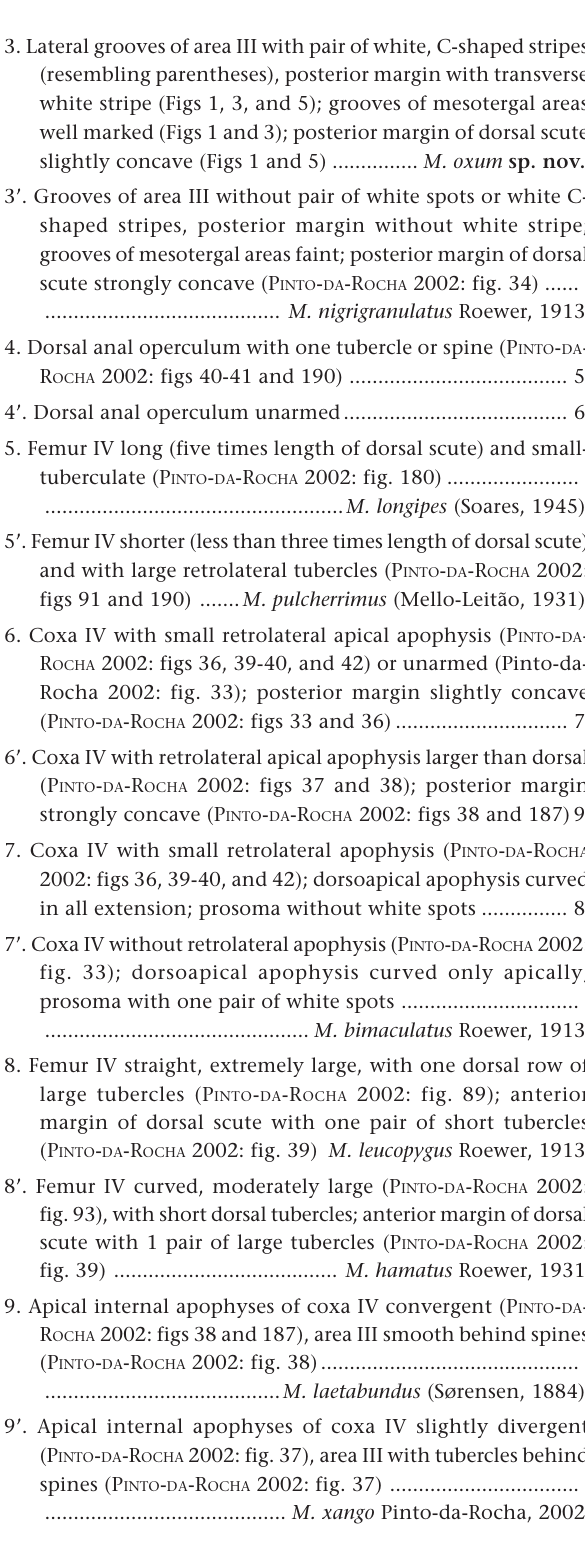
3. Lateral grooves of area III with pair of white, C-shaped stripes (resembling parentheses), posterior margin with transverse white stripe (Figs 1, 3, and 5); grooves of mesotergal areas well marked (Figs 1 and 3); posterior margin of dorsal scute slightly concave (Figs 1 and 5) ............... M. oxum sp. nov. 3’. Grooves of area III without pair of white spots or white C- shaped stripes, posterior margin without white stripe; grooves of mesotergal areas faint; posterior margin of dorsal scute strongly concave (P INTO - DA -R OCHA 2002: fig. 34) ...... 4. Dorsal anal operculum with one tubercle or spine (P INTO - DA - R OCHA 2002: figs 40-41 and 190) ...................................... 5